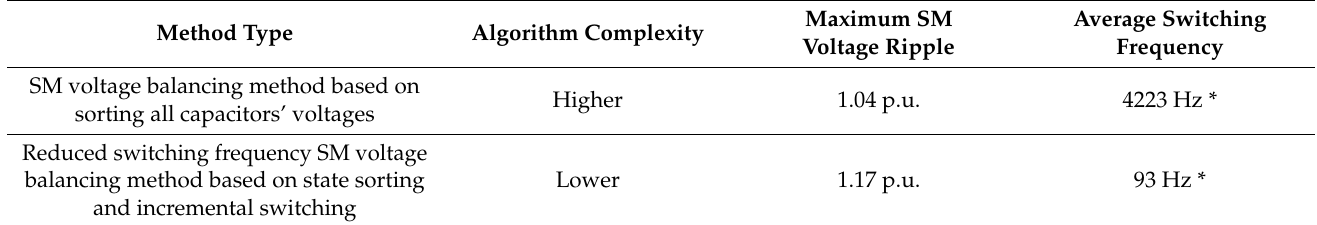
Table 3. Comparison of proposed method and conventional